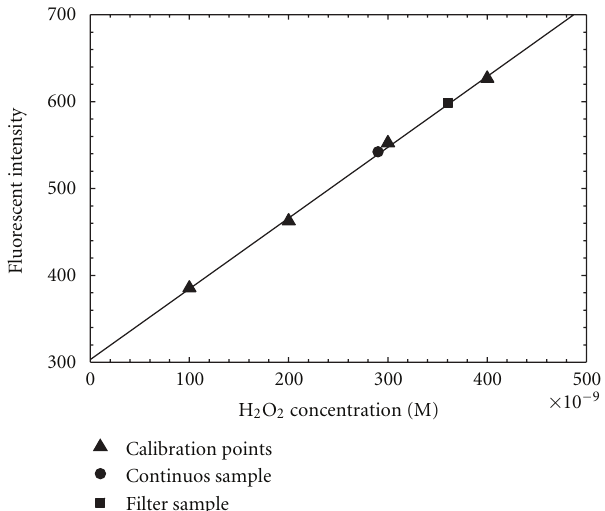
Figure 7: Laboratory test of the automated ROS sampling-analysis system.